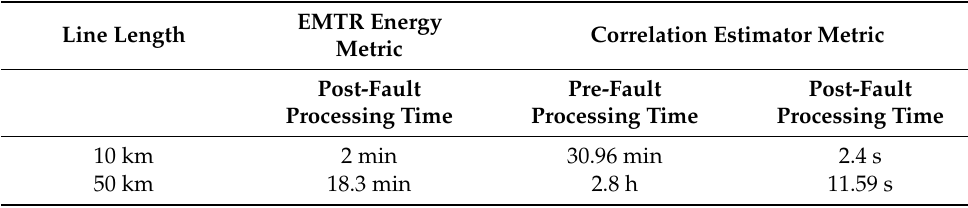
Figure 6. Surge compression by inverse filtering of the transient signal presented in Figure 4. Table 2. Computational efficiency of the EMTR energy metric and correlation estimator metric, while considering a spatial step = 10 m and a frequency bandwidth of 100